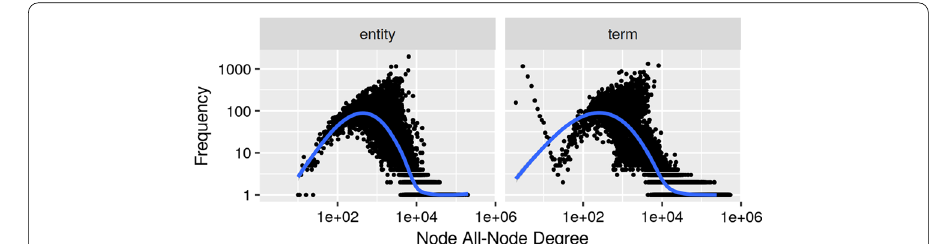
Fig. 11 Node degree distribution, based on connected nodes, for the synonyms model (log–log scale)